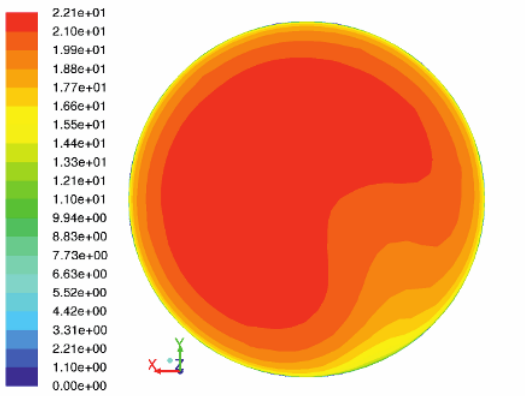
Figure 20: Instantaneous velocity distribution in metering run #3